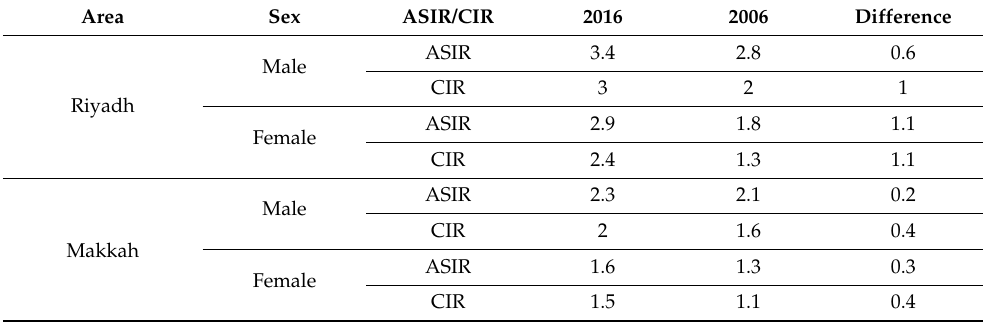
Table 2. The differences between ASIRs and CIRs of brain tumors between 2016 and